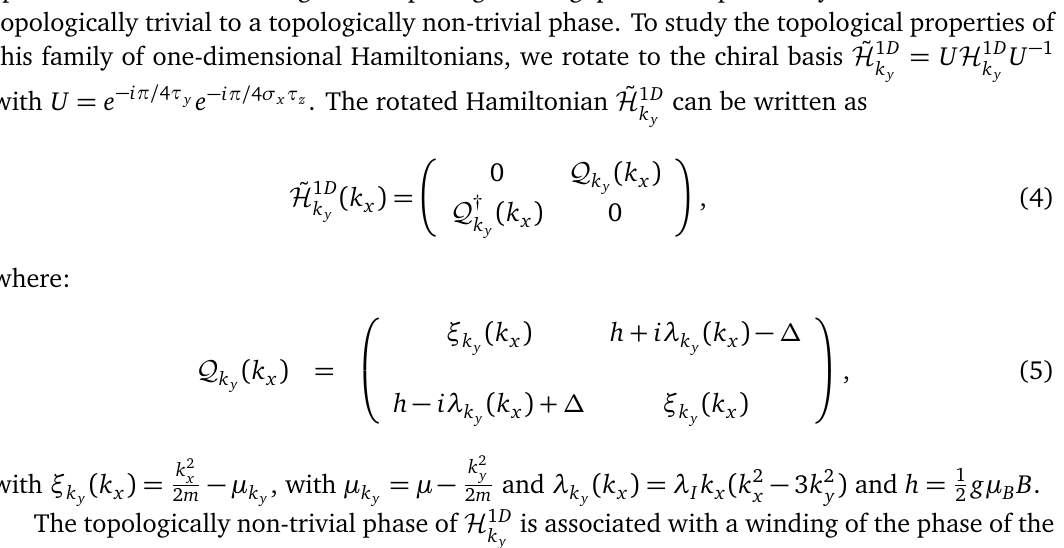
Figure 2: Color plot of the lower positive energy band obtained (labelled 3 in Fig. 1). The spectral gap closes at twelve nodal points in the Brillouin Zone. These are shown as red dots and lie on the λ ( k ) = 0 lines (white, dashed lines). The y − momenta ± k mark the boundaries between the topological and non-topological phases which we cross as we change k y